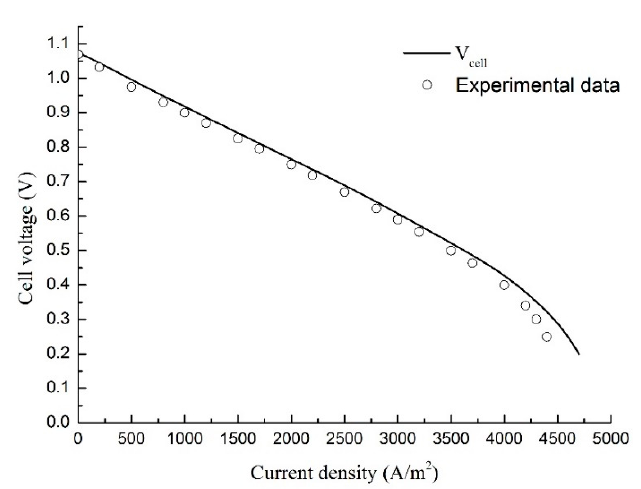
Figure 3. The polarization curves of experiment data and simulation values.